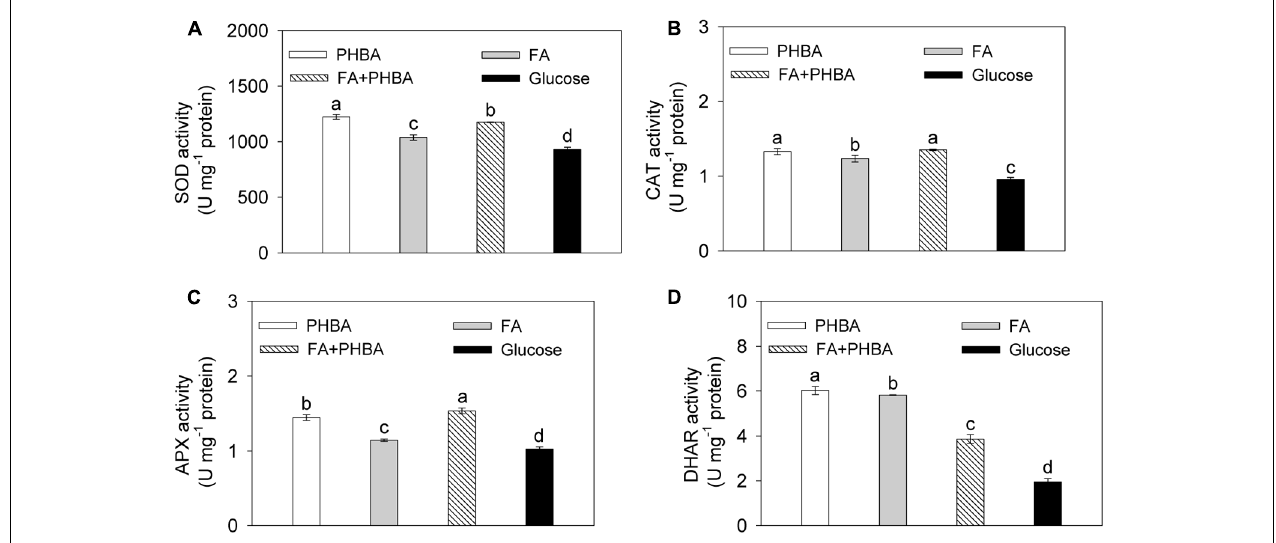
FIGURE 2 | Activities of SOD (A) , CAT (B) , APX (C) , and DHAR (D) in CSY-P13. PHBA, cultured in PHBA; FA, cultured in FA; FA+PHBA, cultured in the mixture of FA and PHBA; glucose, cultured in glucose. Bars represent standard errors of three biological replicates. Values with the different letters are significantly different at P < 0.05 by LSD test using SPSS for Windows 22.0 software (IBM Corp., Armonk, NY, United States).